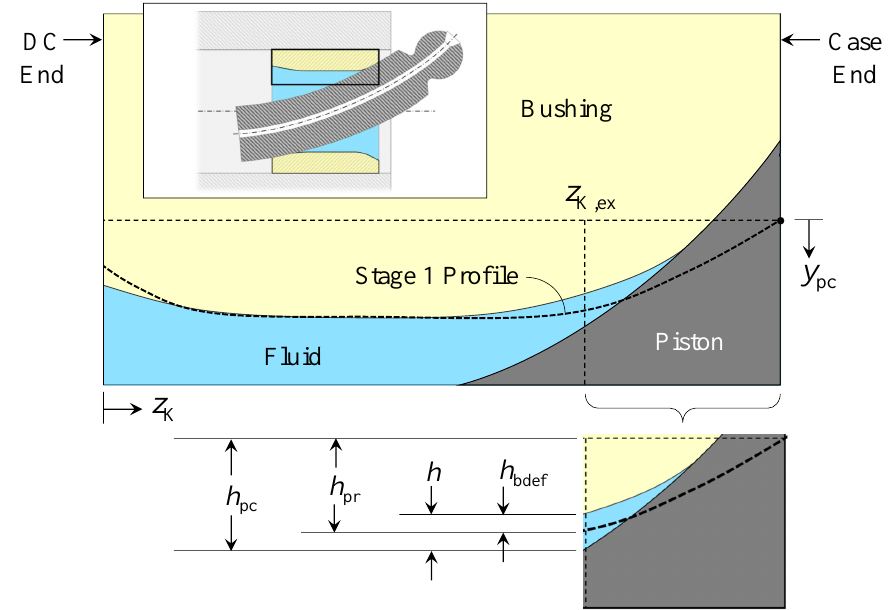
Figure 17. Obtaining the contour of the deformed